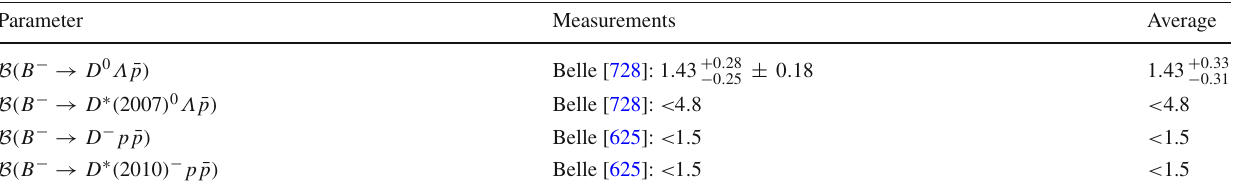
Table 148 Baryonic decays II [ 10 − 5 ] Parameter